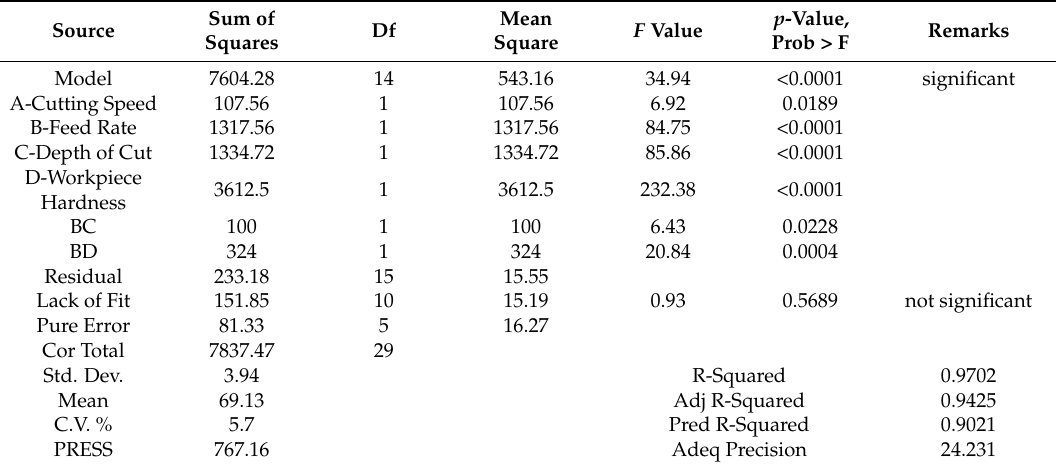
Table 8. ANOVA model of Tangential Force for CBN-I Insert.